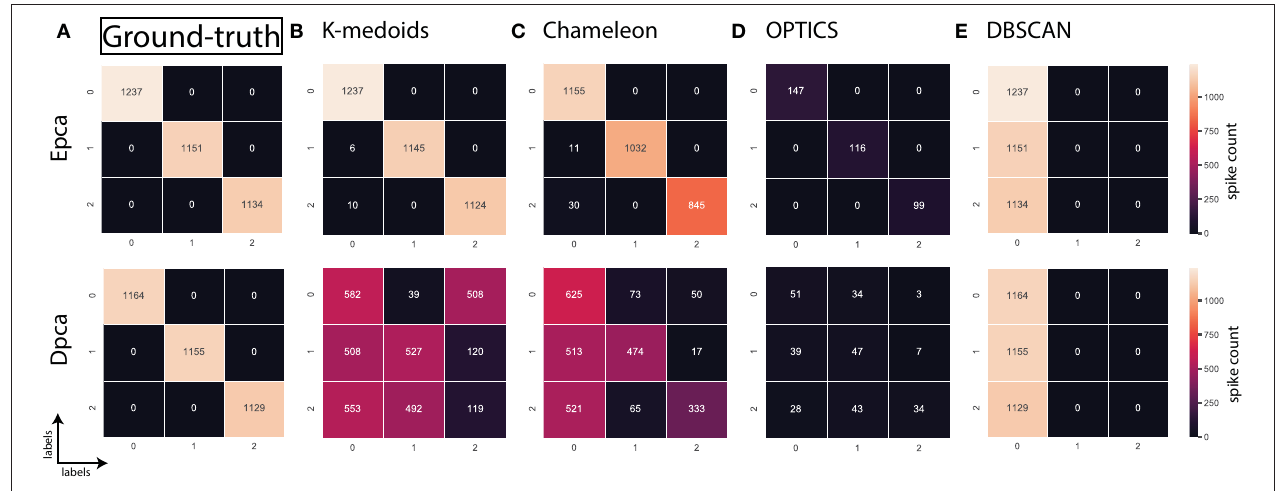
FIGURE 7 | Confusion matrix; relating the performance of an algorithm evaluated using accuracy and false positives. (A) Ground-truth: 100% (B) K-medoids, Epca: 99.54% and Dpca:35.61%, (C) Chameleon, Epca:86.08% and Dpca:41.53%, (D) OPTICS, Epca:10.27% and Dpca:3.28%, (E) DBSCAN, Epca:33.3% and